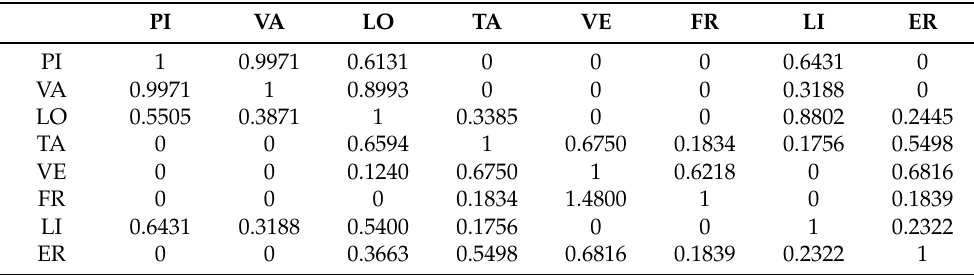
Table 3. Parameters w cd that consider the dependence of the contagion between